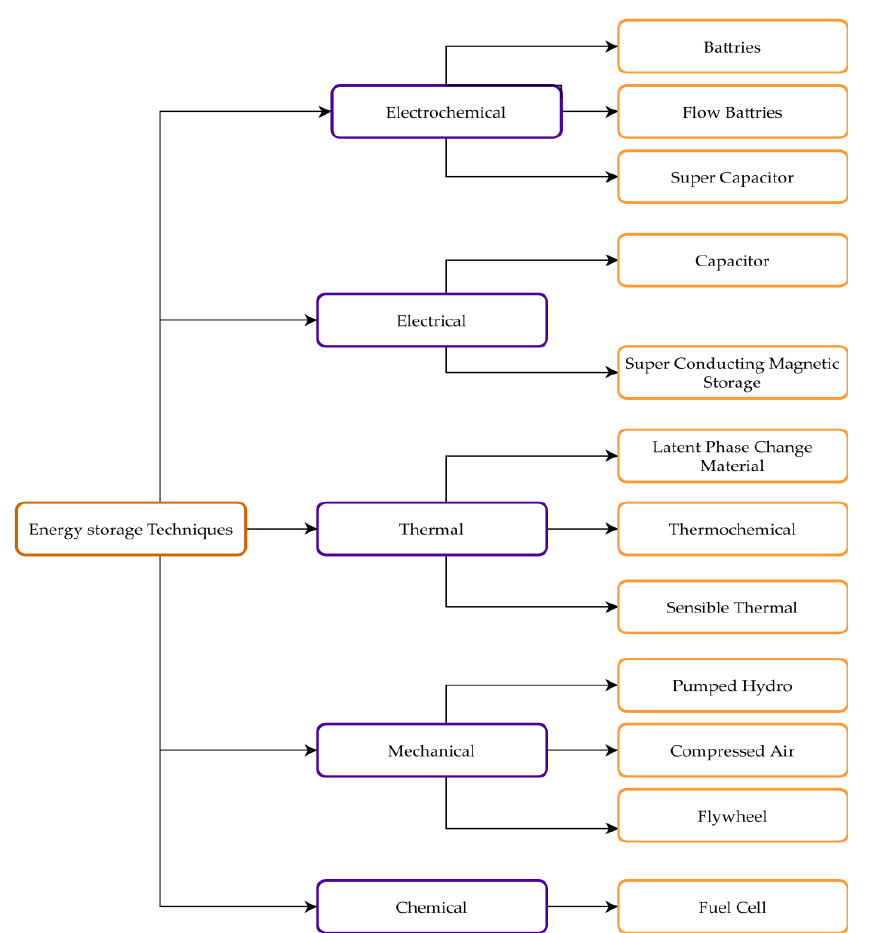
Figure 2. Categories of different energy storage technologies.